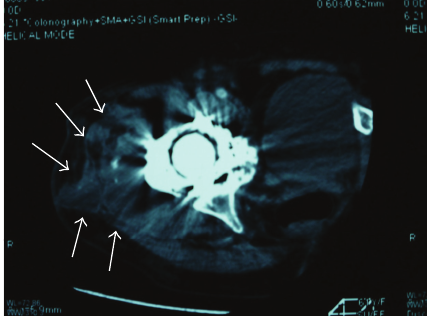
Figure 2: We tested for an arterial bleed with computed tomog- raphy using a contrast medium. Although active bleeding was not observed, a hematoma around the hip joint was visible in this test (white arrows).